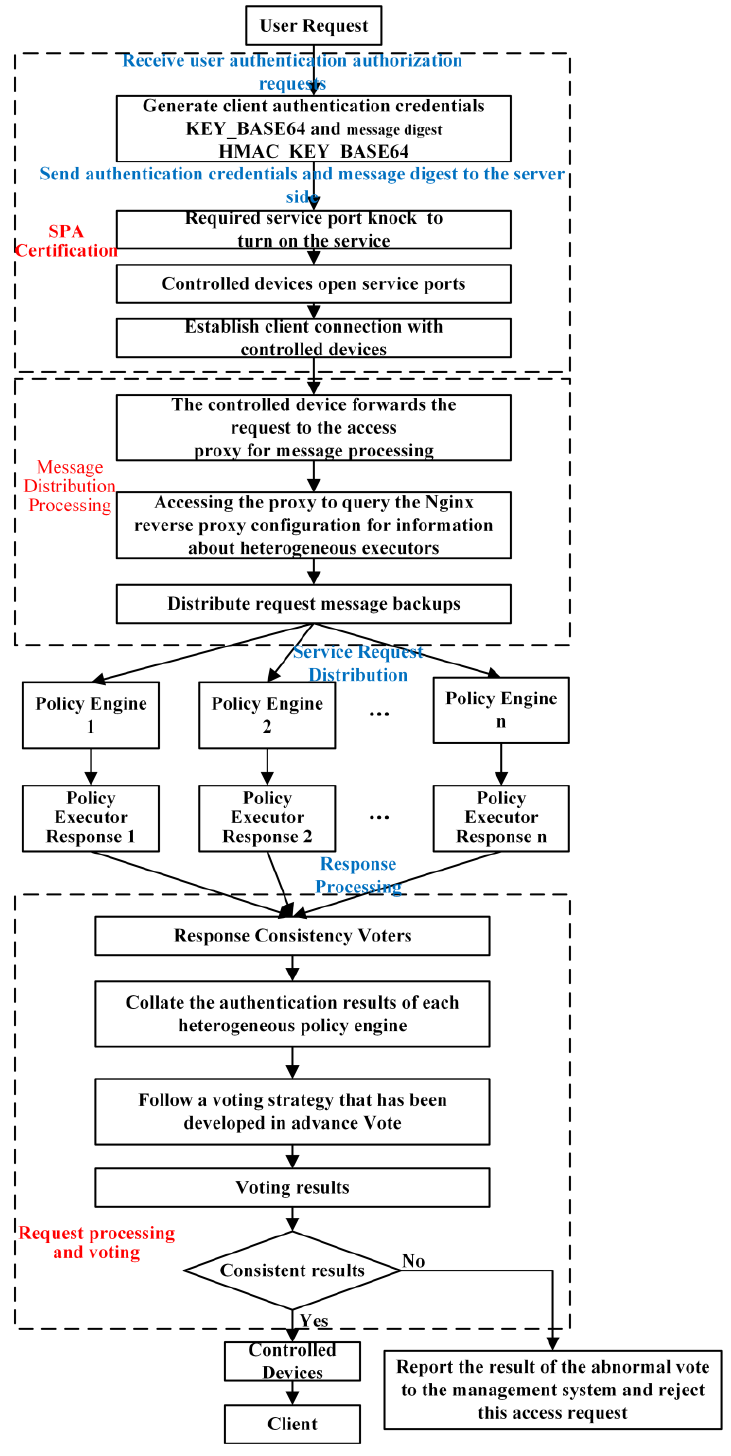
Figure 5. Authentication process.